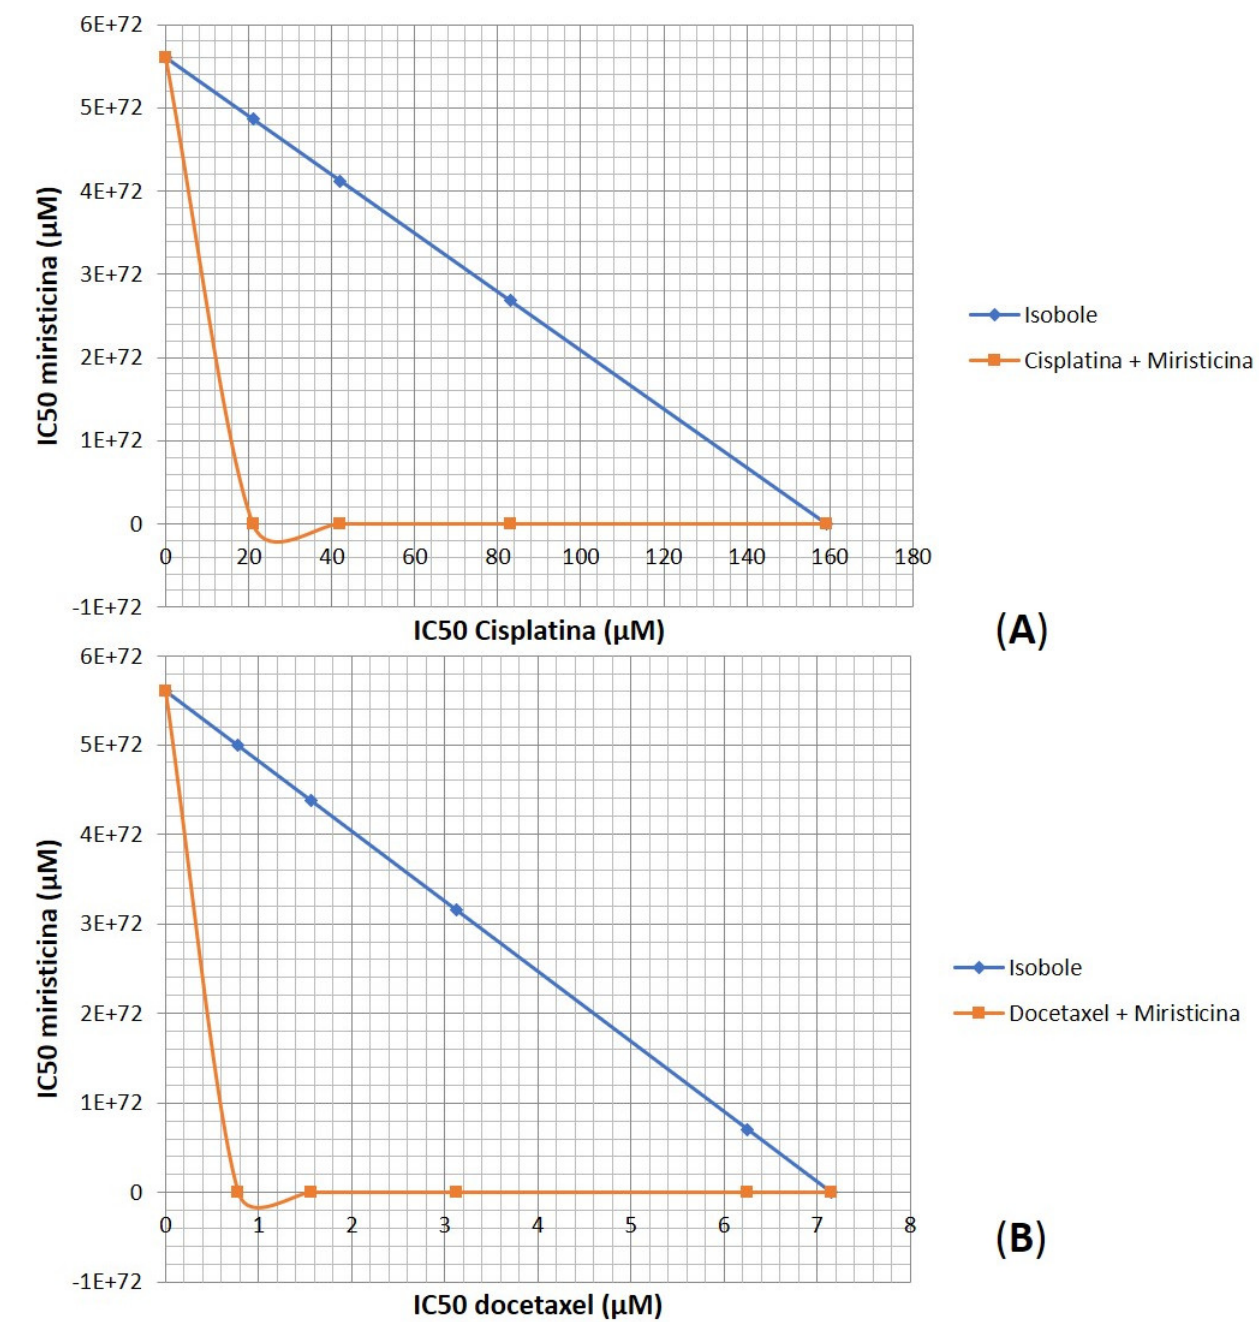
Figure 5. Isobolograms representing the synergistic interaction between myristicin and the chemother- apeutic agents cisplatin ( A ) and docetaxel ( B ) in the NCI/ADR-RES multidrug-resistant ovarian line after 48 h of incubation.